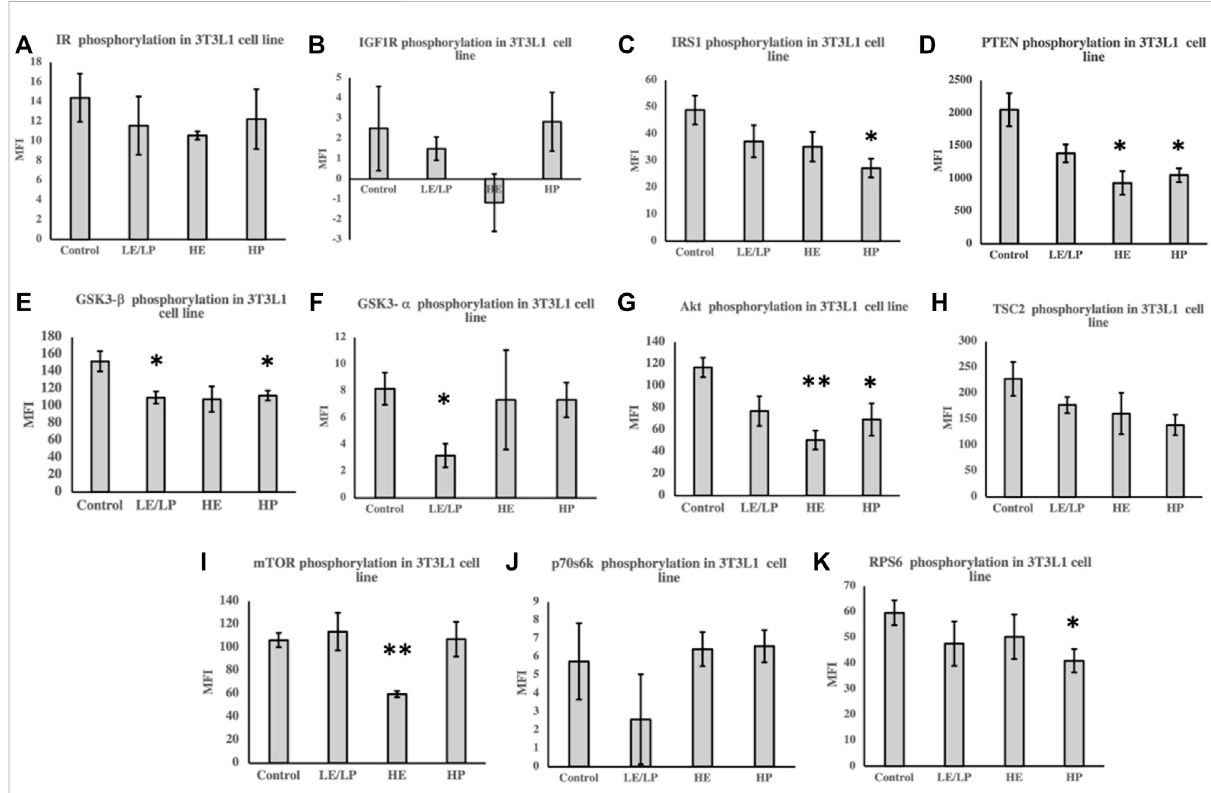
FIGURE 2 Effectofincubating3T3-L1cellswith10%ofserafromdifferentathletegroups(LE/LP:lowendurance/lowpower, HE:highendurance,andHP: high-power and non-athlete control) on the activation of insulin signaling phosphoproteins, including insulin resistance (IR) (A) , insulin-like growth factor 1 receptor (IGF-1R) (B) , insulin receptor substrate 1 (IRS-1) (C) , phosphatase and tensin homolog deleted on chromosome 10 (PTEN) (D) , glycogen synthase kinase 3 beta (GSK3- β ) (E) , glycogen synthase kinase 3 alpha (GSK3- α ) (F) , protein kinase B (Akt) (G) , tuberous sclerosis complex 2 (TSC2) (H) , mammalian target of rapamycin (mTOR) (I) , ribosomal protein S6 kinase beta-1 (p70S6K) (J) , and ribosomal protein S6 (RPS6) (K) . Data are presented as mean ± SEM (* p ≤ 0.05, ** p ≤